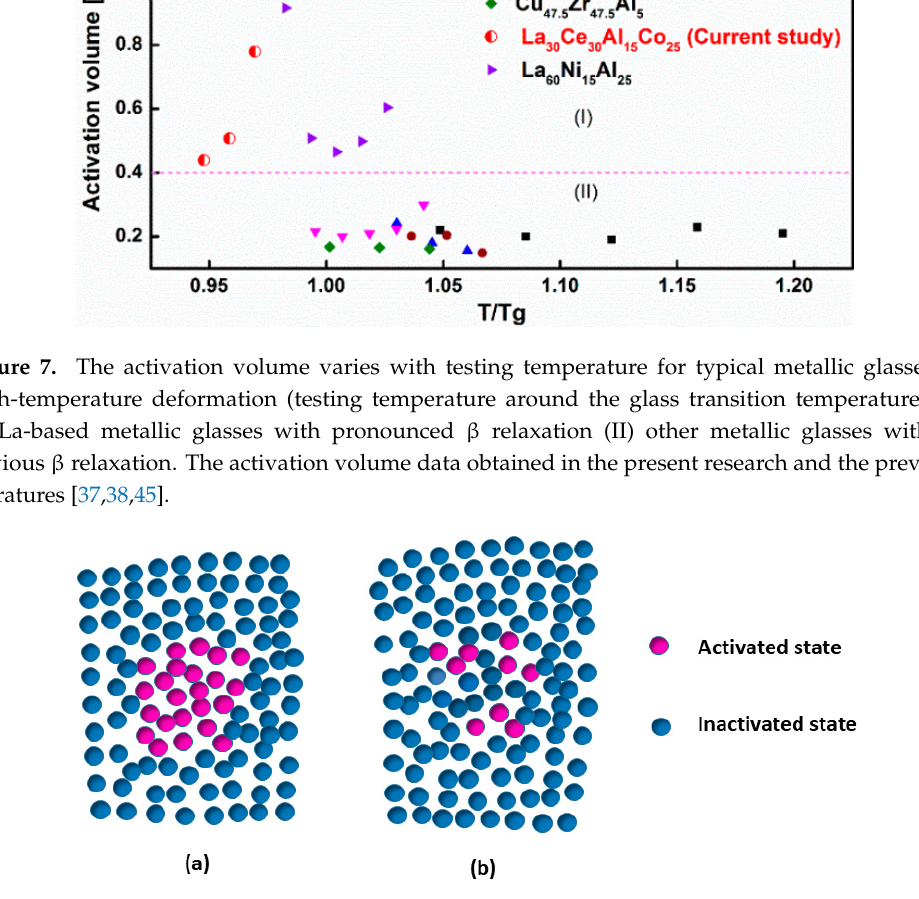
Figure 8. The schematic diagram of activation volumes in metallic glasses at the high-temperature deformation: ( a ) Metallic glasses show a pronounced β relaxation; and ( b ) β relaxation is not evident (i.e., excess wing or shoulder) in metallic glasses.